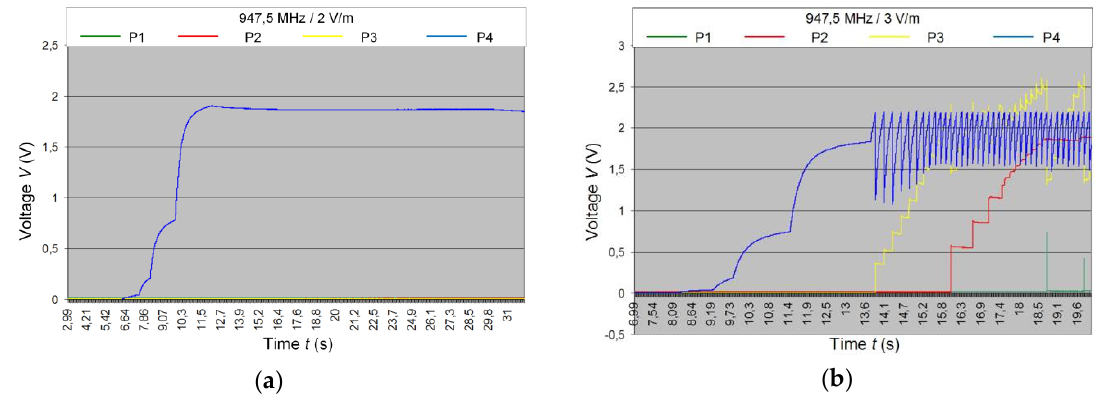
Figure 14. Voltage waveforms in P1-P4 test points for middle frequency of 947.5 MHz: ( a ) At field strength of 2 V / m; ( b ) At field strength of 3 V / m.